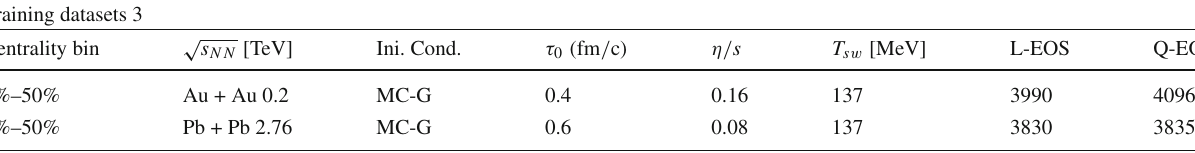
Table 3 Training datasets 3: numbers of cascade-coarse-grained spectra ρ c ( p T ,(cid:6)) computed by the iEBE-VISHNU hybrid model with the MC-Glauber initial conditions in the centrality range 0–50%